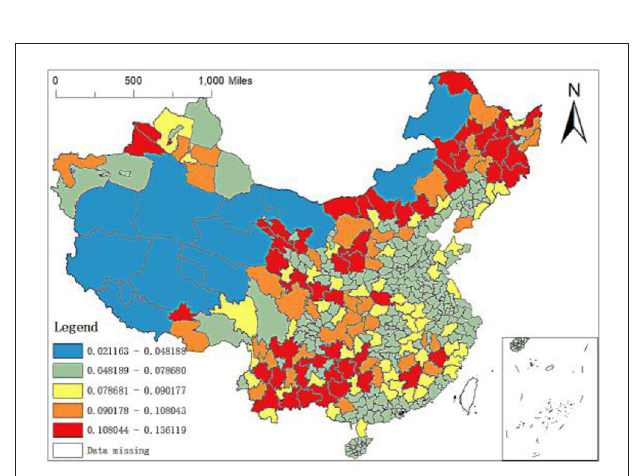
FIGURE 9 | Spatial distribution of regression coefficients of permanent population in MGWR-SAR